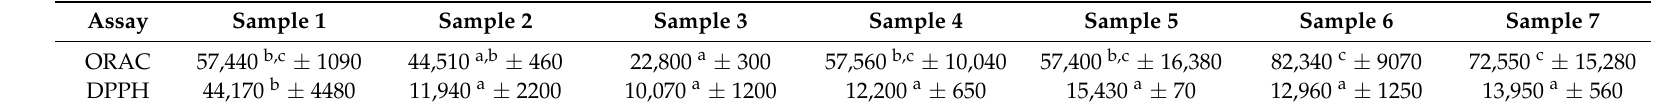
Table 4. Oxygen Radical Absorbance Capacity (ORAC) and 2,2-diphenyl-1-picrylhidracyl (DPPH) antioxidant activity results for each sample. Assay